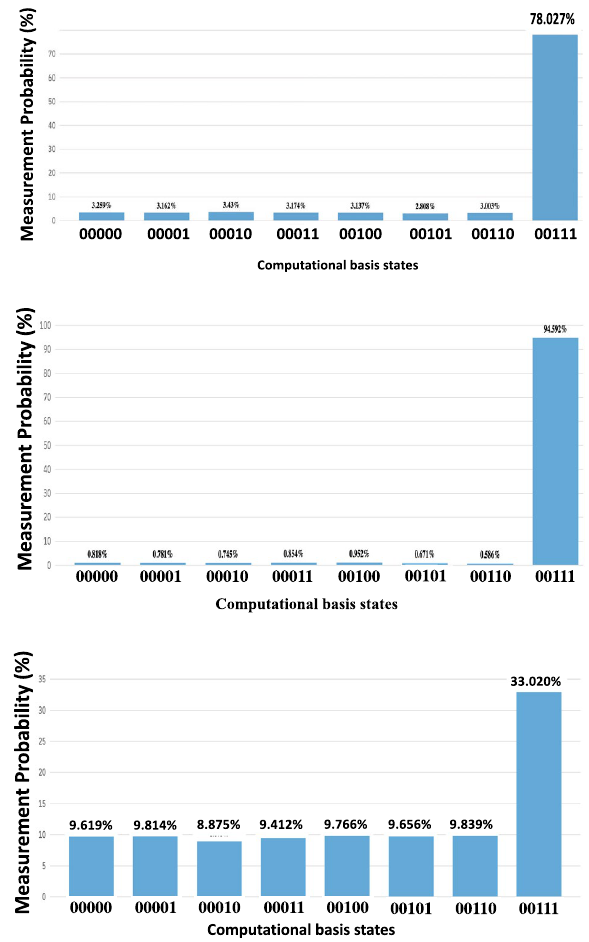
Figure 1. Probability of target state measurement with multiple iterations. The above results were obtained via sampling from simulated quantum state probability distributions after a varying number of GA iterations, repeated 8192 times for each number of GA iterations. The target state is | 111 � , denoted in the figure by | 00111 � . The number of samples establishes the accuracy of the presented probability distributions, which reflect probabilities defined by the state-vectors prior to measurement. Probability distributions obtained from simulations such as these, which sample from distributions defined by state vectors, negligibly diverge from these distributions when the number of samples is sufficient and can therefore be treated as accurate approximations. The approximation errors of the sampled distributions above, quantified by the Kullback– Leibler (K–L) divergence of the sampled distributions from the true distributions, are negligible ( 5.36 × 10 − 4 for one iteration, 8.54 × 10 − 4 for two iterations, and 5.35 × 10 − 4 for three iterations). In this work, K–L divergence is calculated with log base 2. Optimized probability of target state measurement occurs after π 4 iterations, rounded to the nearest integer. For a three-qubit quantum system the optimal number of iterations is √ π 2 3 ≈ 2.22 ≈ 2 , matching the 4